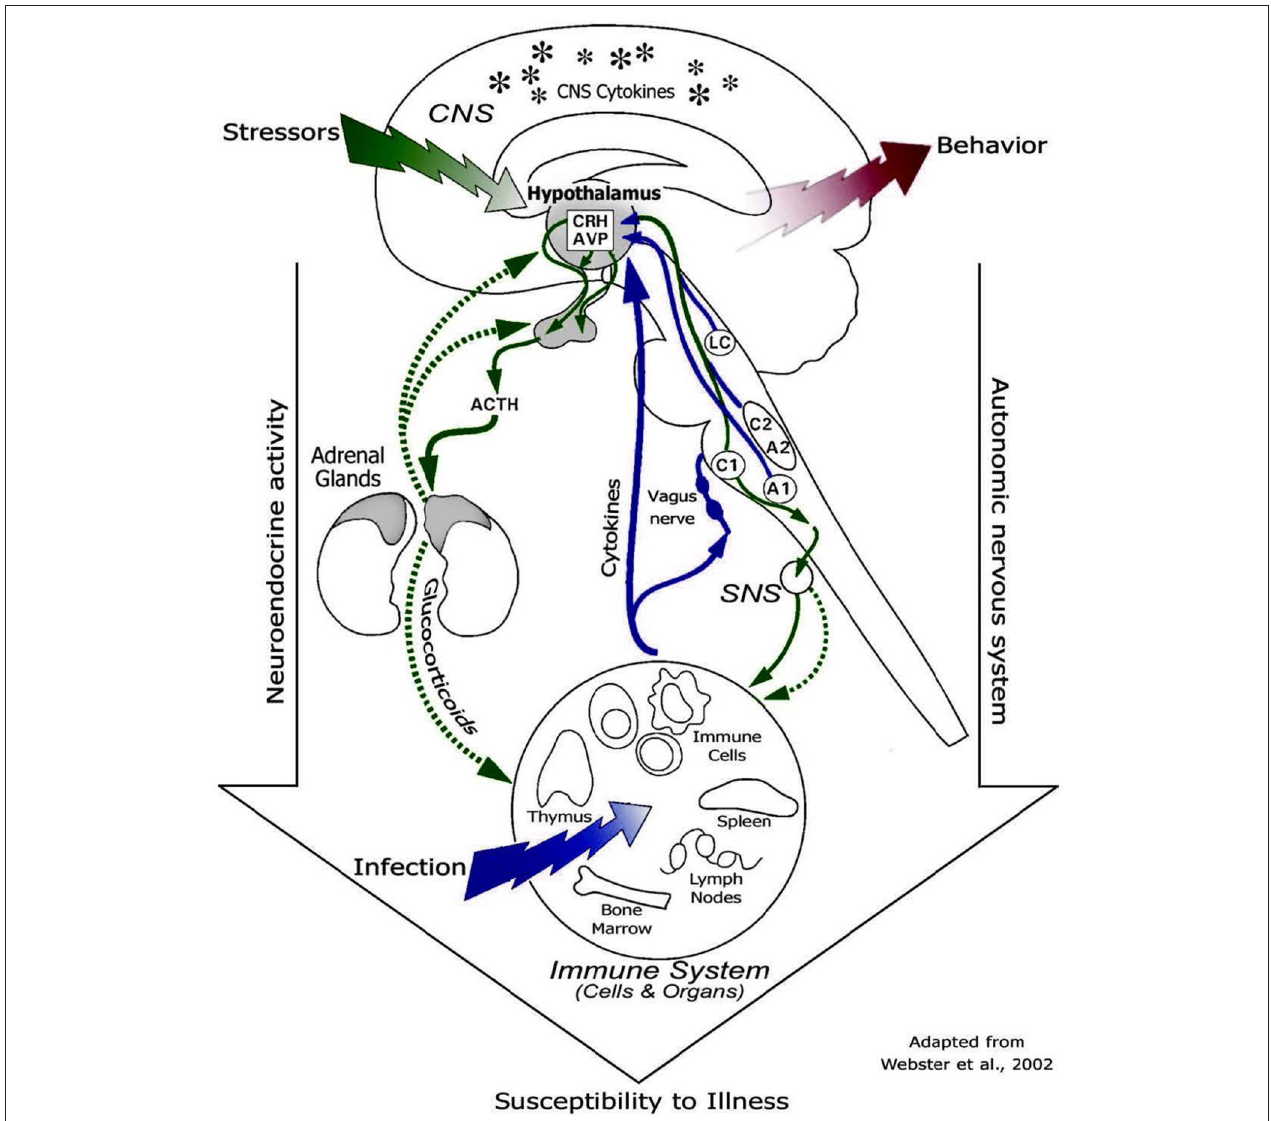
FIGURE 2 | Diagram of routes of communication between the brain and the immune system, including HPA axis, sympathetic nervous system, and cytokine feedback to the brain [ © 2011. Oscar Vegas, Larraitz Garmendia, Amaia Arregi and Arantza Azpiroz. Originally published in “Effects of social stress on immunomodulation and tumor development” under CC BY 3.0 license. Available from Vegas et al.